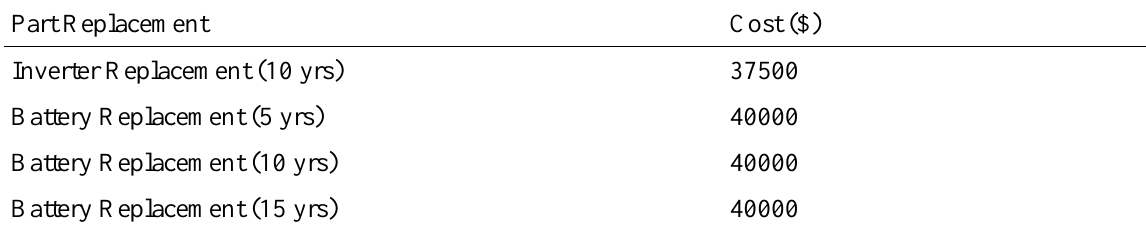
Table 4. Part replacement expenditure Part